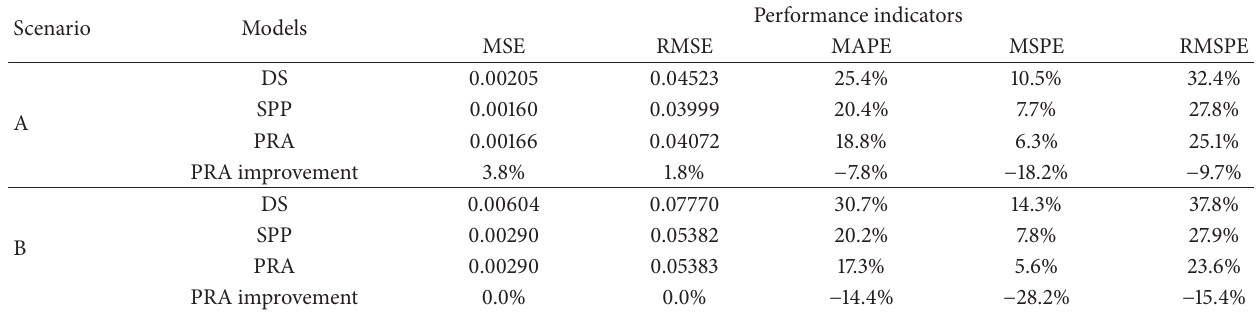
Table 5: Estimation accuracy of link probe